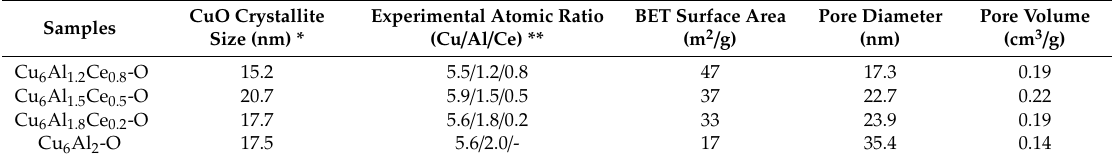
Table 1. Structural and textural features of the Cu 6 Al 2-x Ce x -O samples.